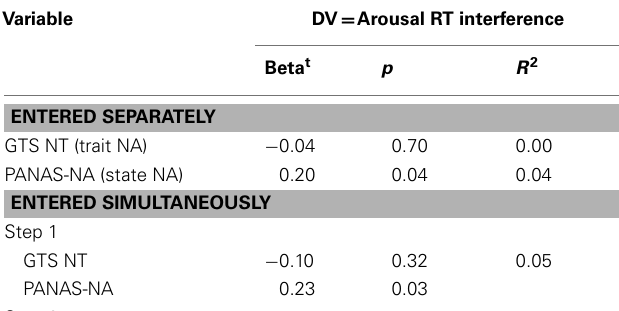
Table 1 | Regression analyses for behavioral data. Table 2 | Brain areas moderated by trait and state negative affect and correlations with behavior.